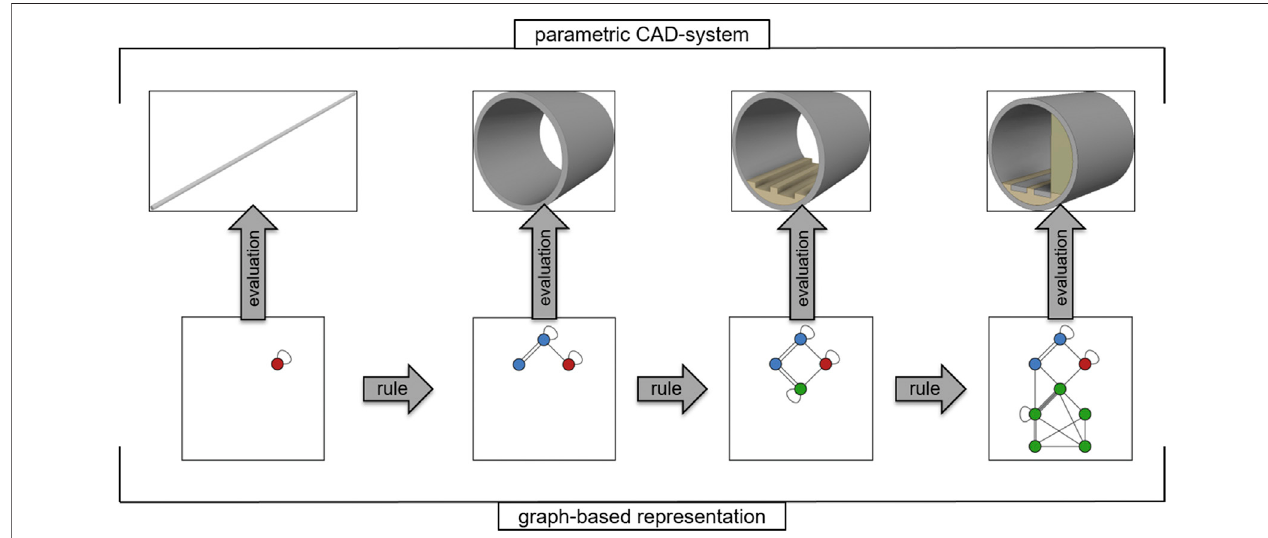
FIGURE 14 | Gradual Re fi nement of tunnel geometry by means of graph rewriting and according to a level of development concept (Vilgertshofer and Borrmann, 2017).